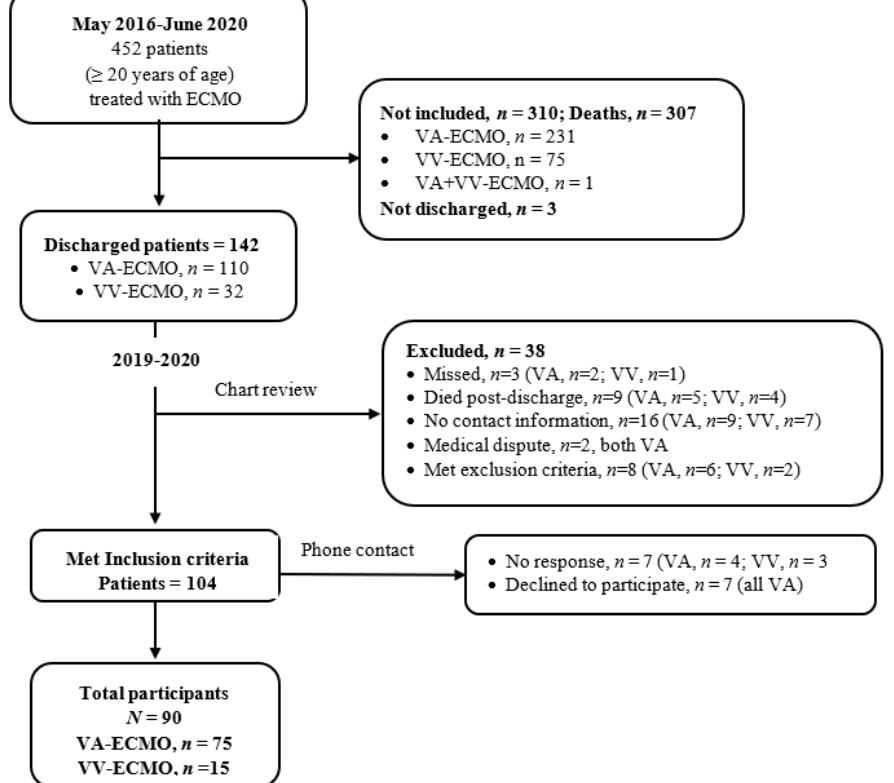
Figure 1. Flow chart of participant selection for data collected 2019–2020. To increase the amount of data for both modes of ECMO at a ratio close to 1:1, data from patients who had received VV-ECMO ( n = 52) between April 2006 and April 2016 were included. These data were collected between October 2015-October 2016 using the same criteria as the 90 patients included in the analysis. A flowchart for the selection of these 52 participants is shown in Figure 2.